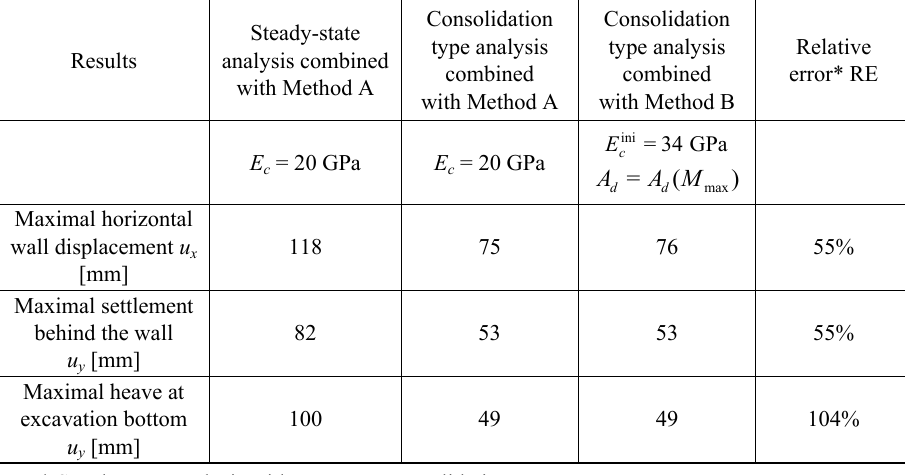
Table 4. Comparison of maximal displacements obtained for two analysis